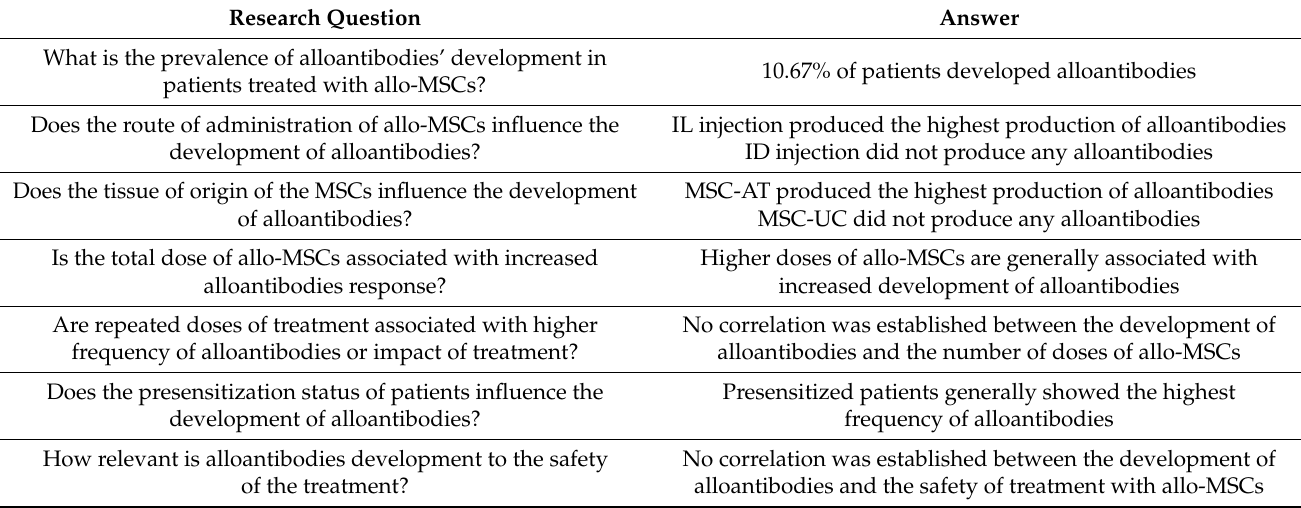
Table 2. Main research questions posed, and results obtained in the qualitative